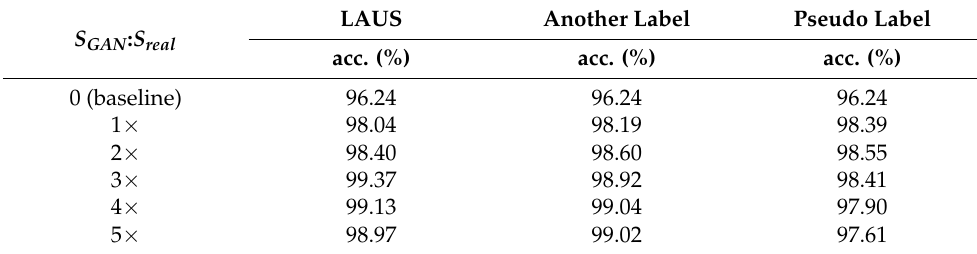
Table 2. Comparing LAUS with related